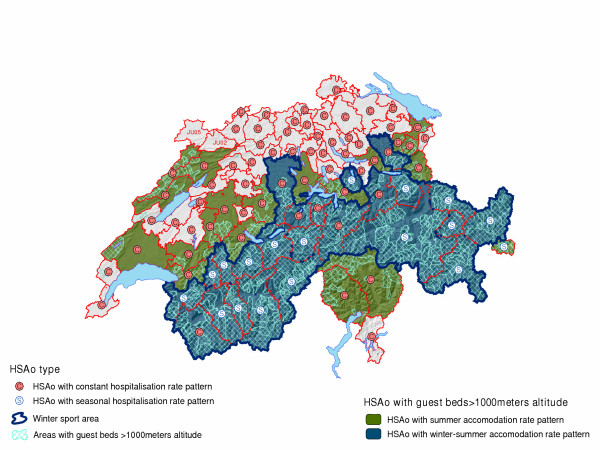
Seasonal and constant HSAo in Switzerland. 83 HSAo in Switzerland of which 24 lay within the winter sport area and of which 18 show a seasonal pattern in hospital emergency admission rates(S).